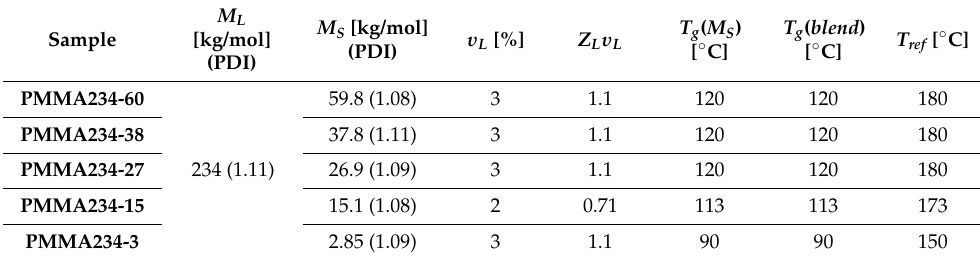
Table 1. Molecular characteristics of purchased PMMA samples and bidisperse